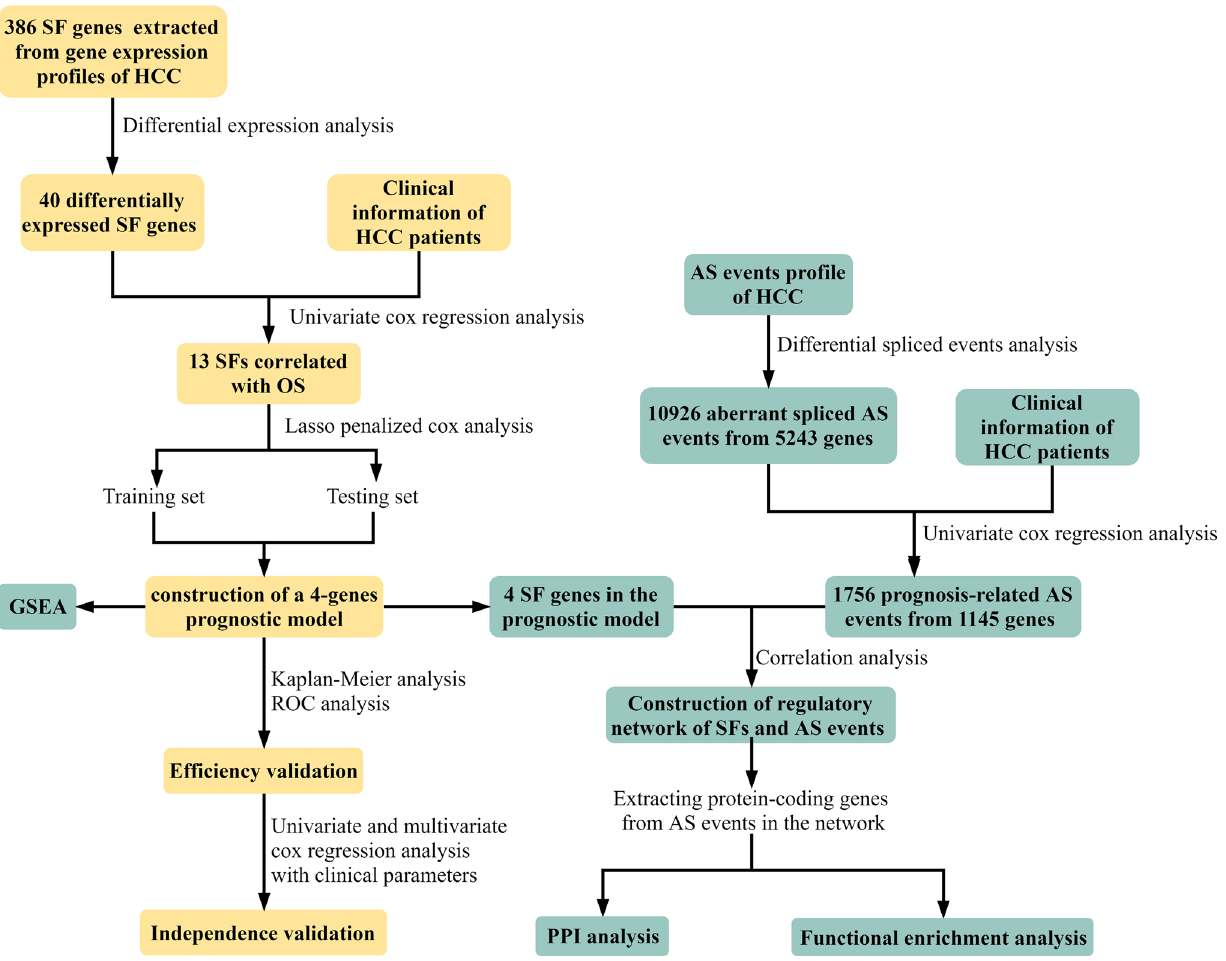
Figure 1. The approach and workflow for the exploration of clinical value and molecular functions of splicing factors (SFs) in HCC. The flowchart was drawing using visio2013 (https:// produ cts. office. com/ en/ visio/ flowc hart- softw